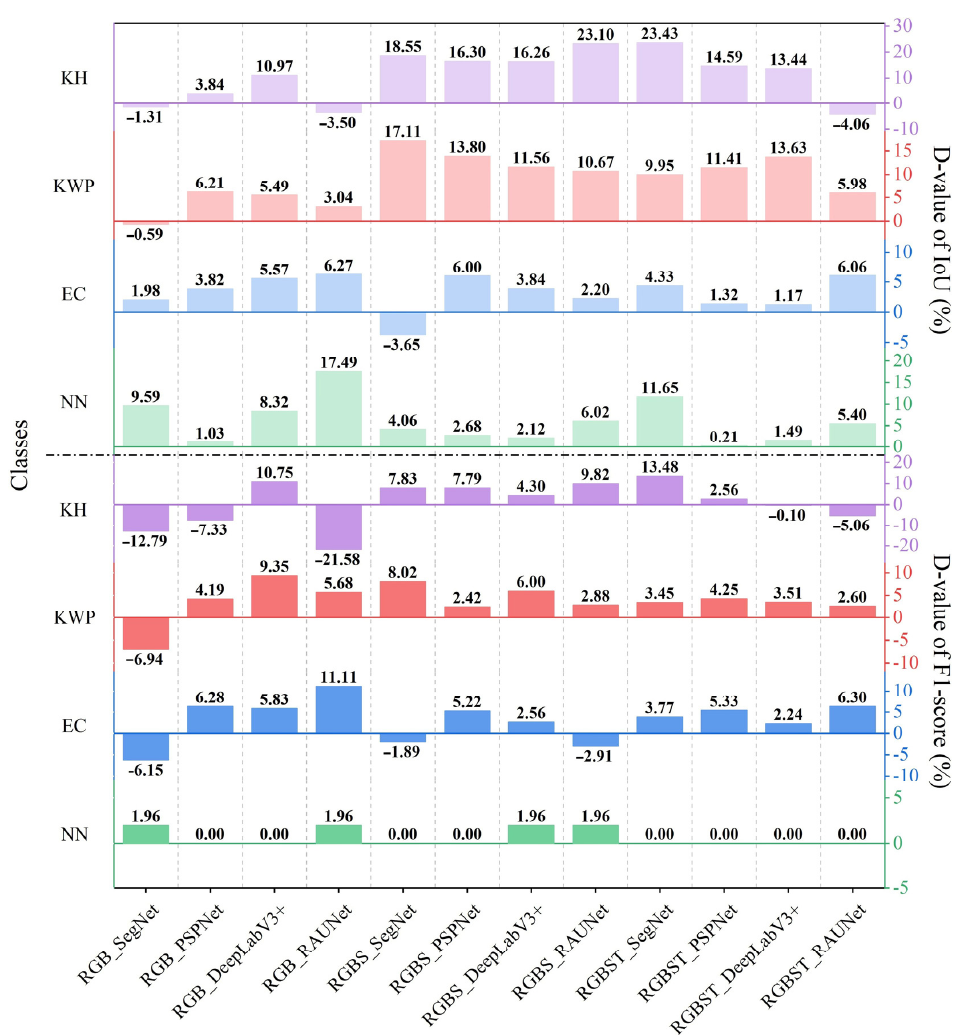
Figure 12. The accuracy differences of IoU and F1-score between OCC and MCC models for karst wetland vegetation.